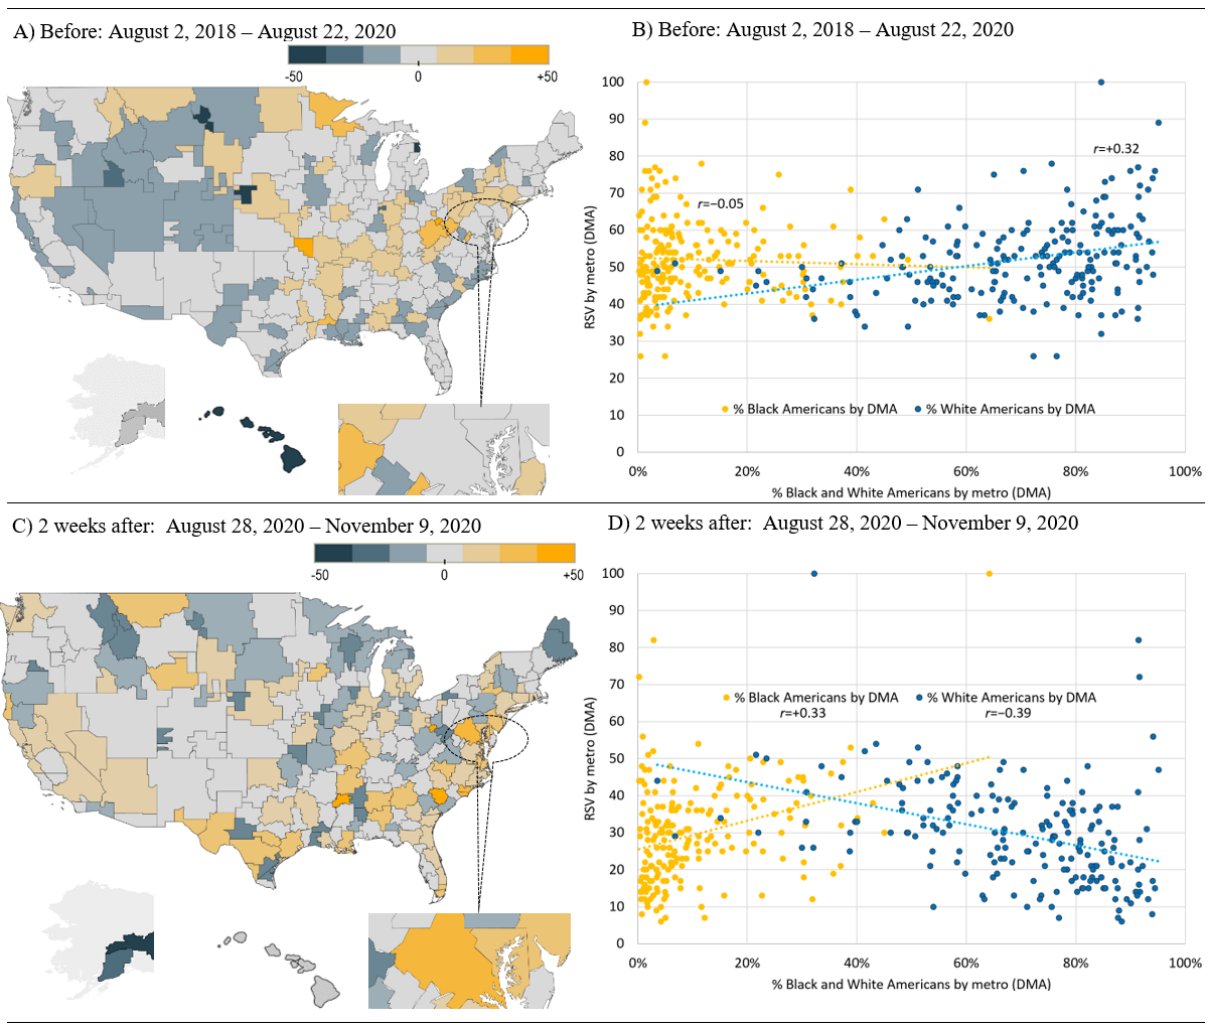
Figure 5. Shifts in demographics and Google relative search volumes for colon cancer by metropolitan area before and after Chadwick Boseman’s death. Metropolitan areas are delineated based on Nielsen designated market areas. The shading scale is based on the difference between the relative search volume value for each metropolitan area and the mean relative search volume for all states during the specified period. DMA: designated market